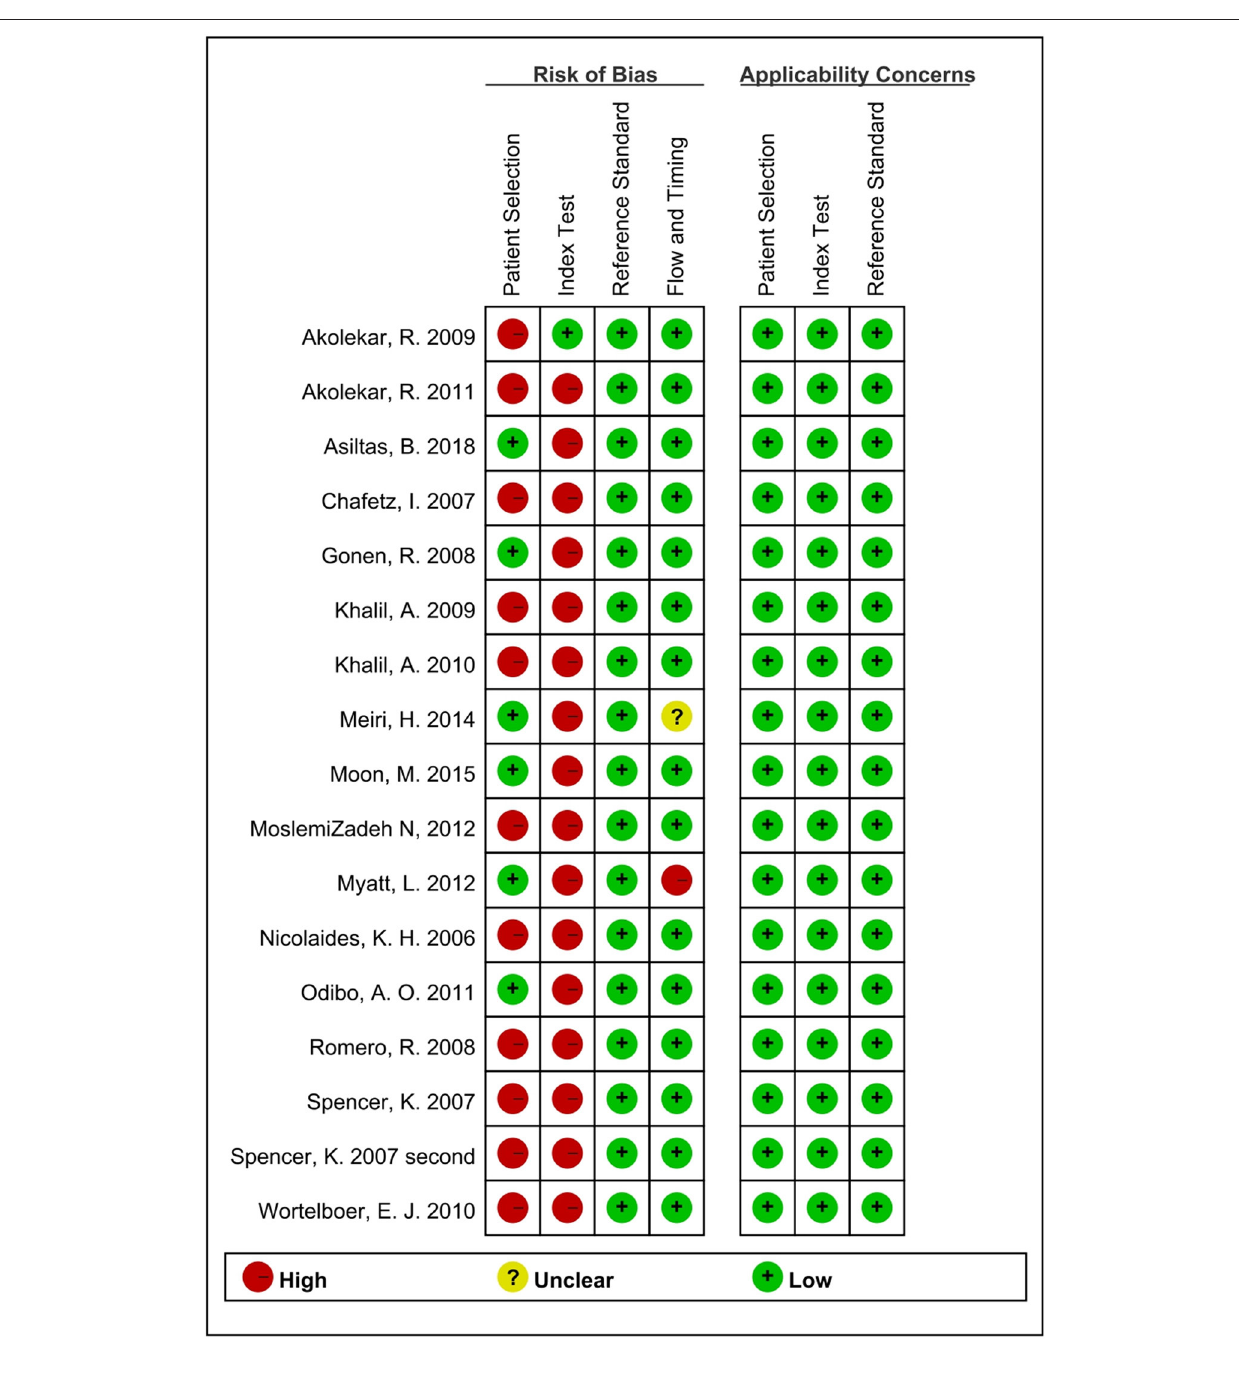
FIGURE 2 | Quality analysis of included